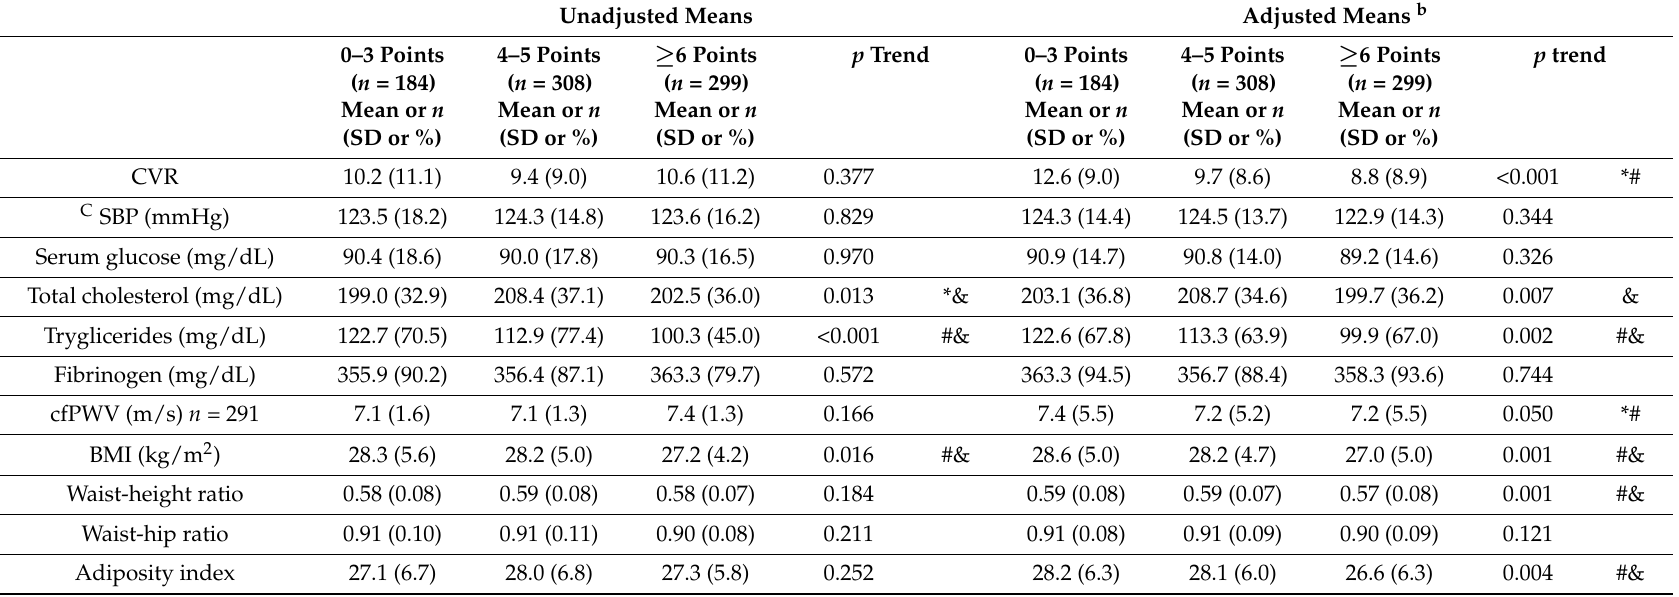
Table 5. Cardiovascular risk, mean cardiovascular risk factors and obesity indexes by score of ATLANTIC diet and lifestyle index.